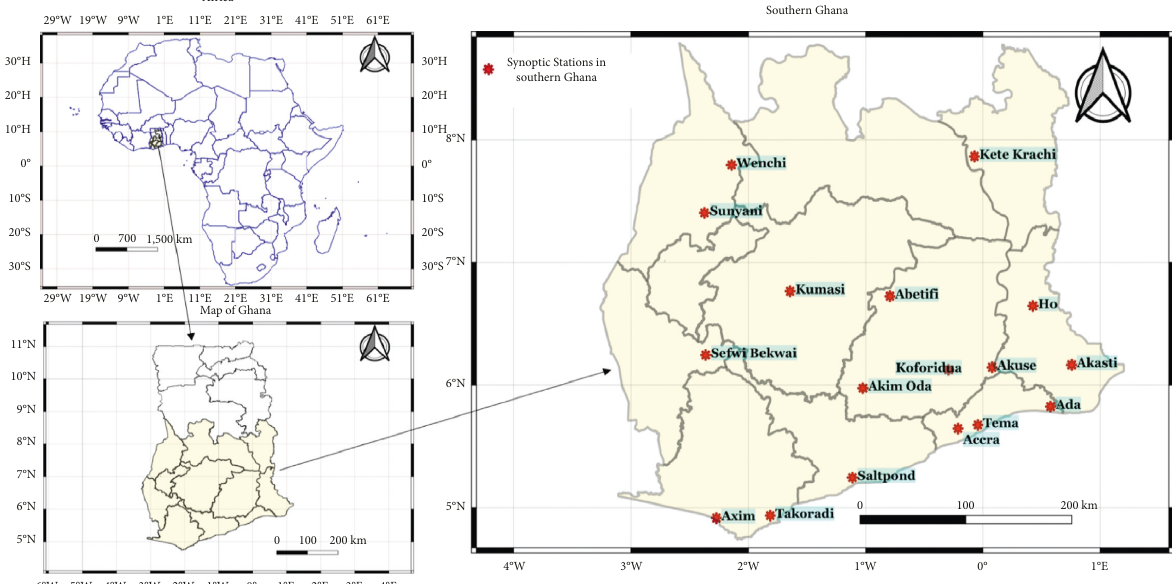
Figure 1: Map showing the various synoptic stations over southern Ghana. The map was created using QGIS software. The coordinates of the Ghana Meteorological Agency’s synoptic stations were used.